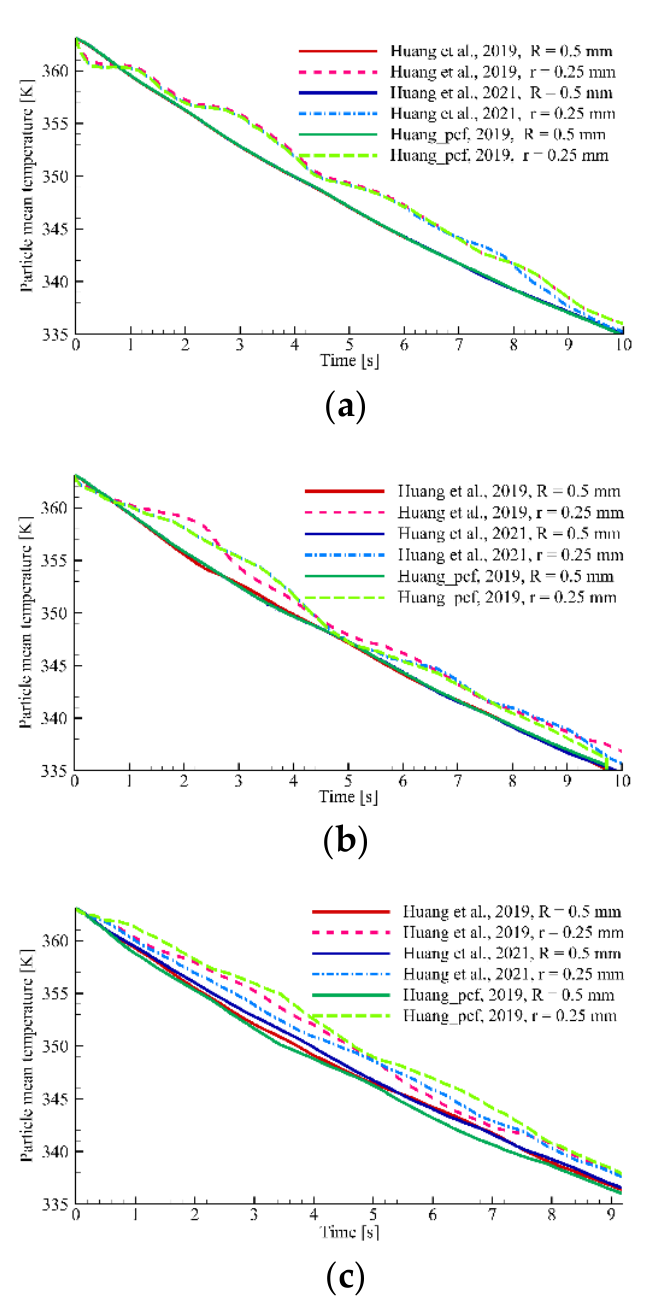
Figure 6. Variation in particle mean temperature at different particle number ratio between large and small particles: ( a ) 1:1; ( b ) 1:2; ( c ) 1:4. Huang et al., 2019 [9], Huang et al., 2021